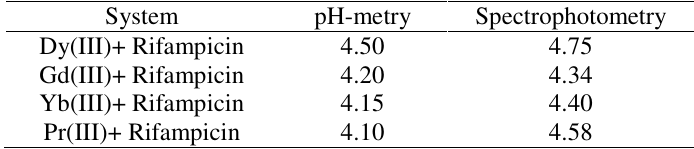
Table 4. Metal-ligand stability constants (log K) values obtained by pH-metry and spectrophotometry techniques (Ionic strength = 0.08